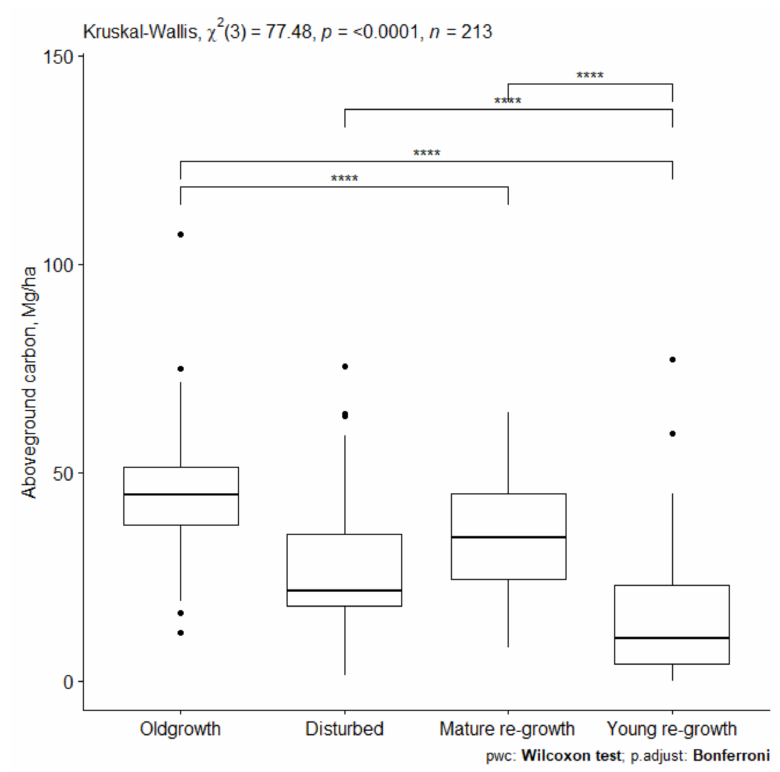
Figure 3. Comparison of old-growth, disturbed, mature re-growth (>30 years), and young re-growth (<30 years). Statistical significances are indicated: p -value < 0.001 ‘***’. Source: Graph by the